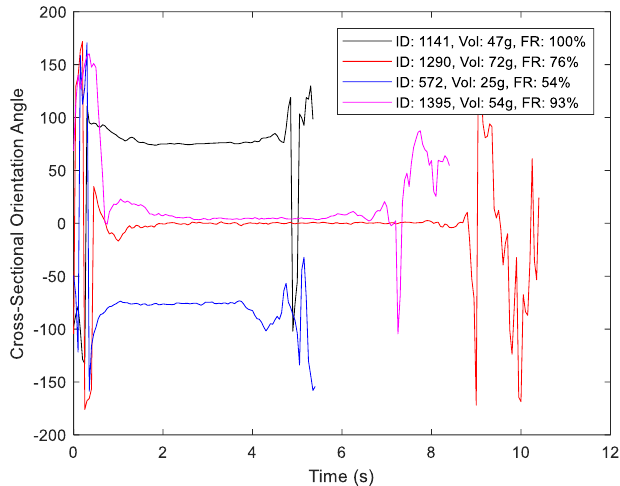
Figure 5. Position of the sensor in the cross-sectional plane of the bottle for four randomly chosen drinks (stationary intervals indicate a lack of rotation about the vertical axis of the bottle).